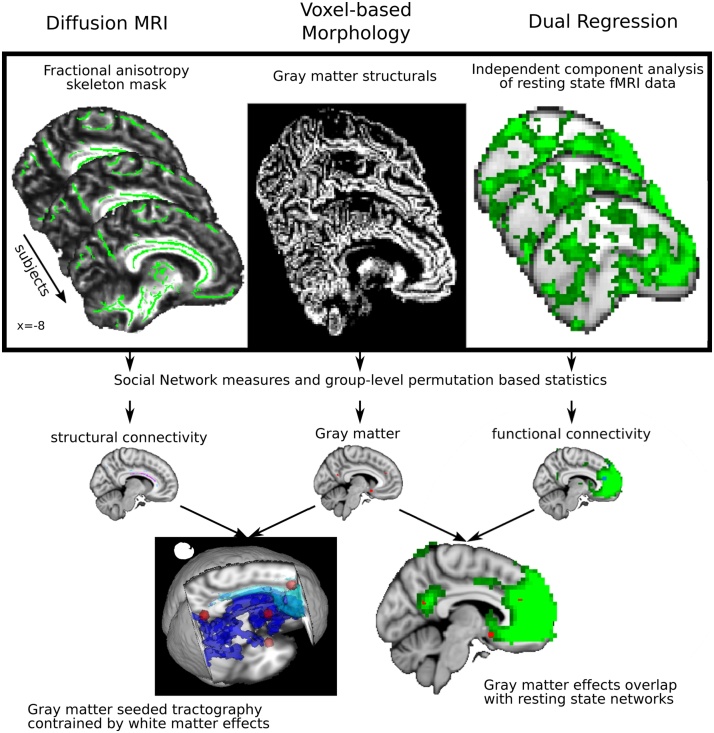
Schematic depicts the overall methodological approach of the study. In the top panel, illustrated for 3 subjects, from left to right we analyzed DMRI, structural and rsfMRI data. We related differences in WM (purple-turquoise), GM (yellow) and functional coupling within RSNs (blue), to individual measures of SNS (mid panel). These techniques were integrated as illustrated by the converging arrows on the lower panel. We used WM tracts, where fractional anisotropy covaried with SNS (dark blue) to constrain probabilistic tractography analyses (turquoise) seeded from social GM clusters (red, bottom left). We also compared the spatial topography of RNSs (green) with social GM clusters (red, bottom right). (For interpretation of the references to colour in this figure legend, the reader is referred to the web version of this article).